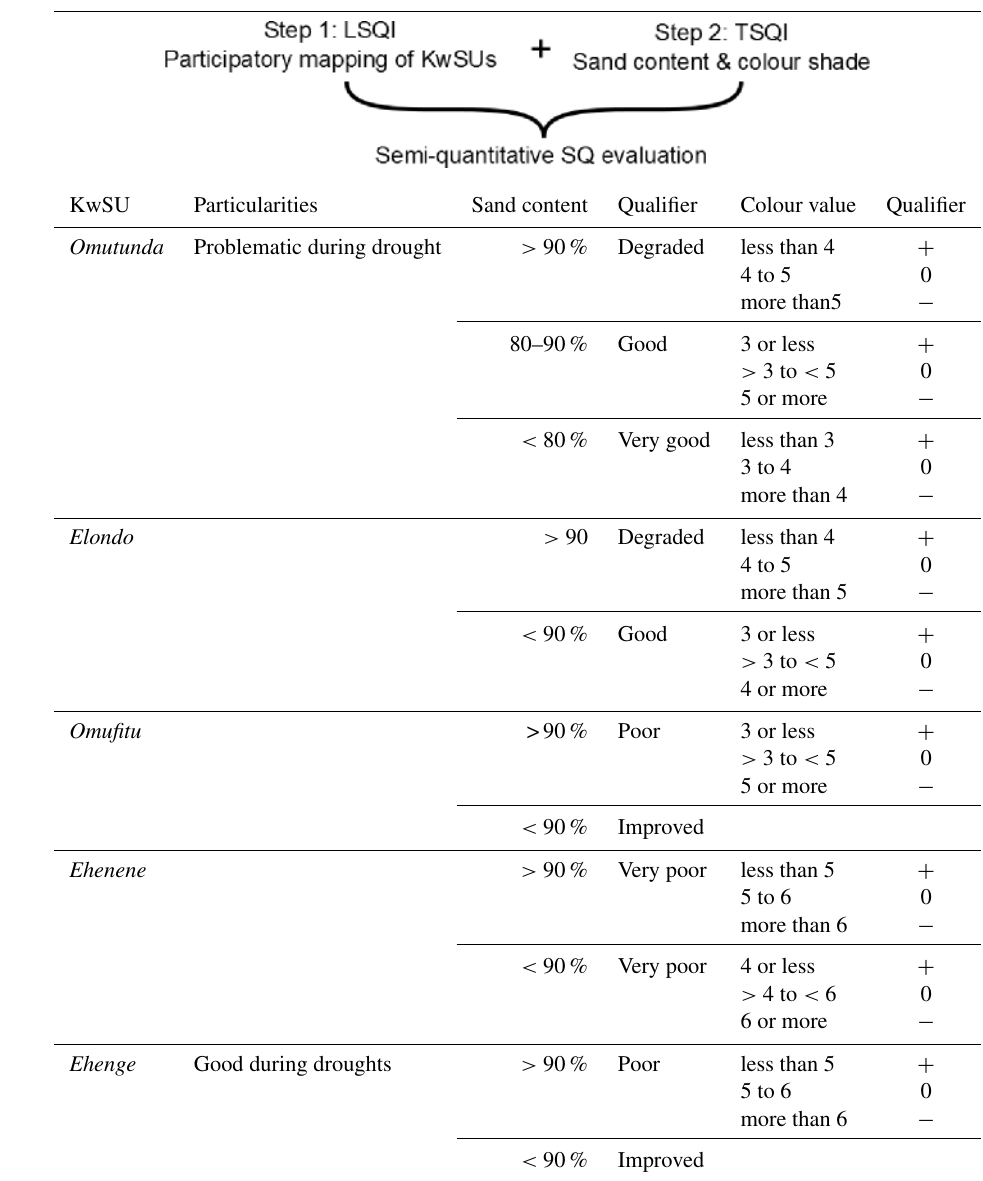
Table 9. Schematic representation of the suggested SQ toolbox. It integrates local soil quality indicators (LSQI) and technical soil quality indicators (TSQI) to create a semi-quantitative evaluation. Hierarchical SQ evaluation. The evaluation starts with LSQI and classifies location into Oshikwanyama soil units (KwSU); afterwards technical assessment is used to determine chemical fertility potential (sand) and the soil organic carbon (SOC) status (colour).